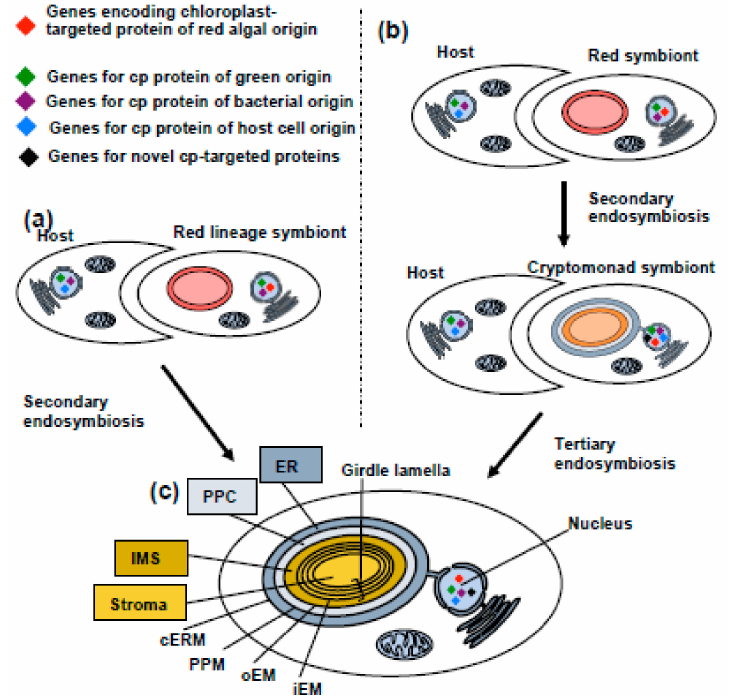
Figure 2. Origins and structure of the diatom chloroplast. This schematic figure shows two alternative hypotheses for the origins of the diatom chloroplast [4,25,42]: ( a ) secondary endosymbiosis of a red alga by a common ancestor of photosynthetic stramenopiles or ( b ) tertiary endosymbiosis of a cryptomonad-like organism, itself harbouring a chloroplast of secondary, red algal endosymbiotic origin. Either the host or the endosymbionts may have possessed genes retained from a cryptic endosymbiont of green algal origin [25,43–45], although this remains debated [44,45]. Other chloroplast-targeted proteins (indicated by the presence of coloured diamonds) may have been recruited from bacterial sources, either in the host or symbiont, proteins or paralogous copies of proteins previously targeted to other host cell organelles or may even have evolved de novo at the point of endosymbiosis [25]. ( c ) shows a schematic diagram of the four membranes surrounding the diatom chloroplast, adapted from [4]. Abbreviations are as follows: cERM; chloroplast endoplasmic reticular membrane;